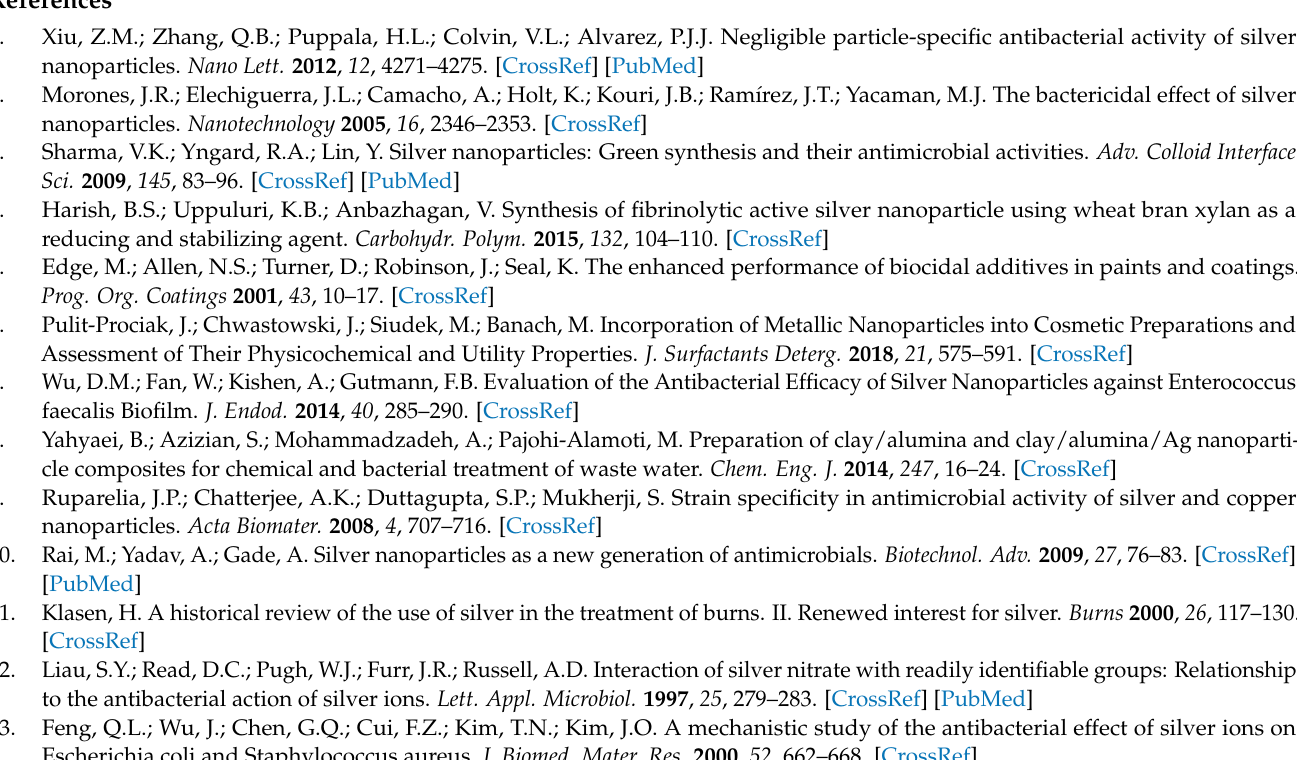
Figure S7: Ag + release kinetics monitored by conductimetry in aqueous medium over the time for CNC/AgNP hybrids at various AgNP content with and without H 2 O 2 redox post-treatment (i.e., 160 µ L H 2 O 2 ). Figure S8: Comparison between long-term diffusion tests for CNC/AgNP hybrids at various AgNP contents with and without H 2 O 2 redox post-treatment. Cases of complete and incomplete bacterial inhibition (i.e., lysis) are indicated. Table S1: R-factor and Chi-square values for linear combination fitting procedure applied to the XANES region of CNC/AgNP hybrid suspensions at different AgNP contents. Table S2: EXAFS fit results for CNC/AgNP hybrid suspensions with increasing AgNP content. Table S3: Comparison of MIC in various hybrid systems reported in the